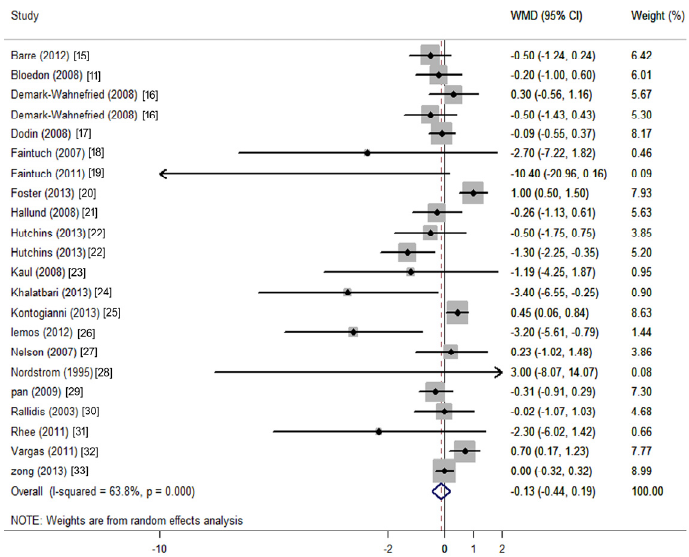
Figure 2. Meta-analysis of flaxseed intervention on net changes (95% CI) of CRP. CI: confidence interval. WMD: weighted mean difference; The horizontal lines denote the 95% CIs: some of which extend beyond the limits of the scales. The square represents the point estimate of each study. The diamond represents the overall pooled estimate of the treatment effect.